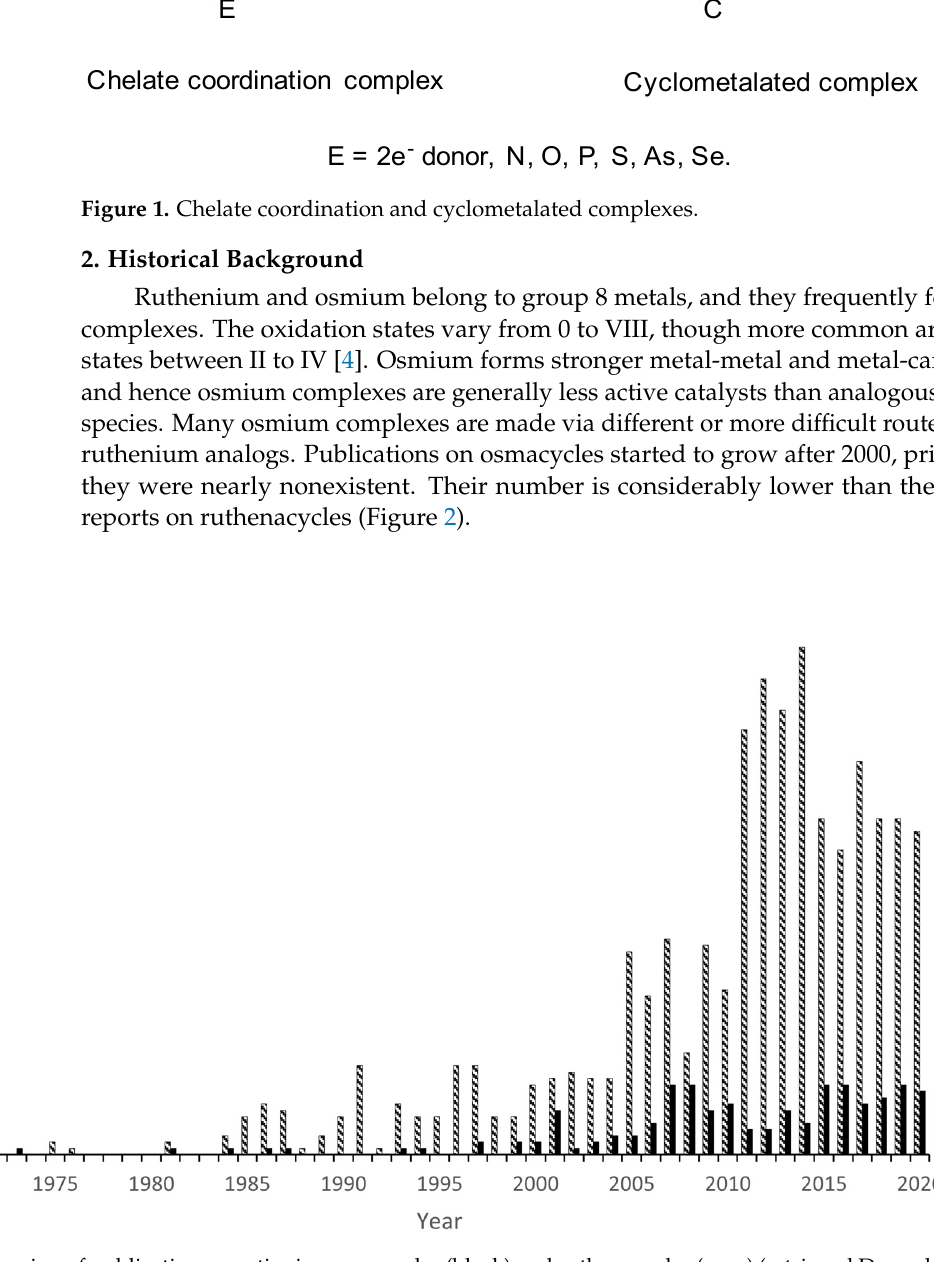
Figure 2. Year progression of publications mentioning osmacycles (black) and ruthenacycles (grey) (retrieved December 2020, SciFinder with keywords: osmacycle, osmium AND cyclometalated, osmium AND cyclometallated, cyclometalated AND osmium, metalacycle AND osmium or ruthenacycle, ruthenium AND cyclometalated, cyclometallated AND ruthenium, cyclometalated AND ruthenium, metalacycle AND ruthenium).